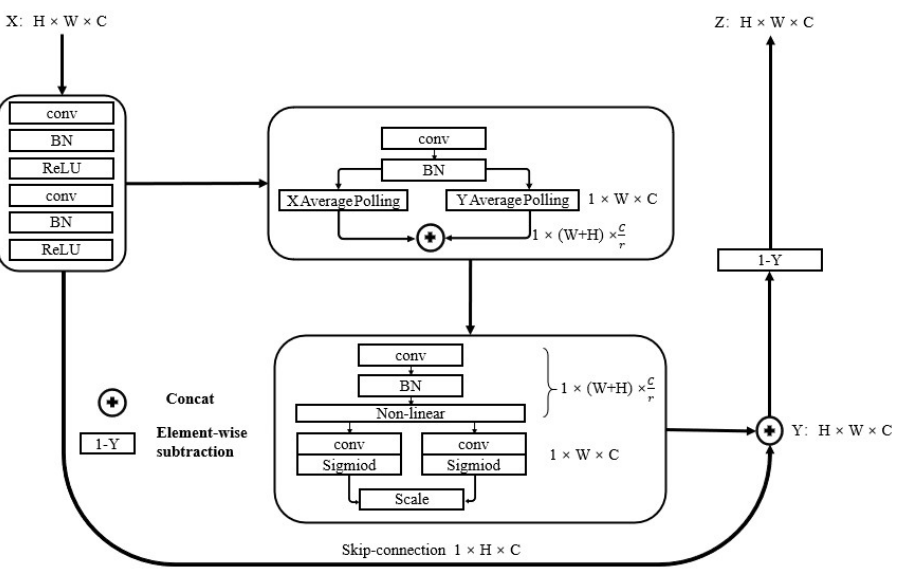
Figure 3. Structure of the anti-attention